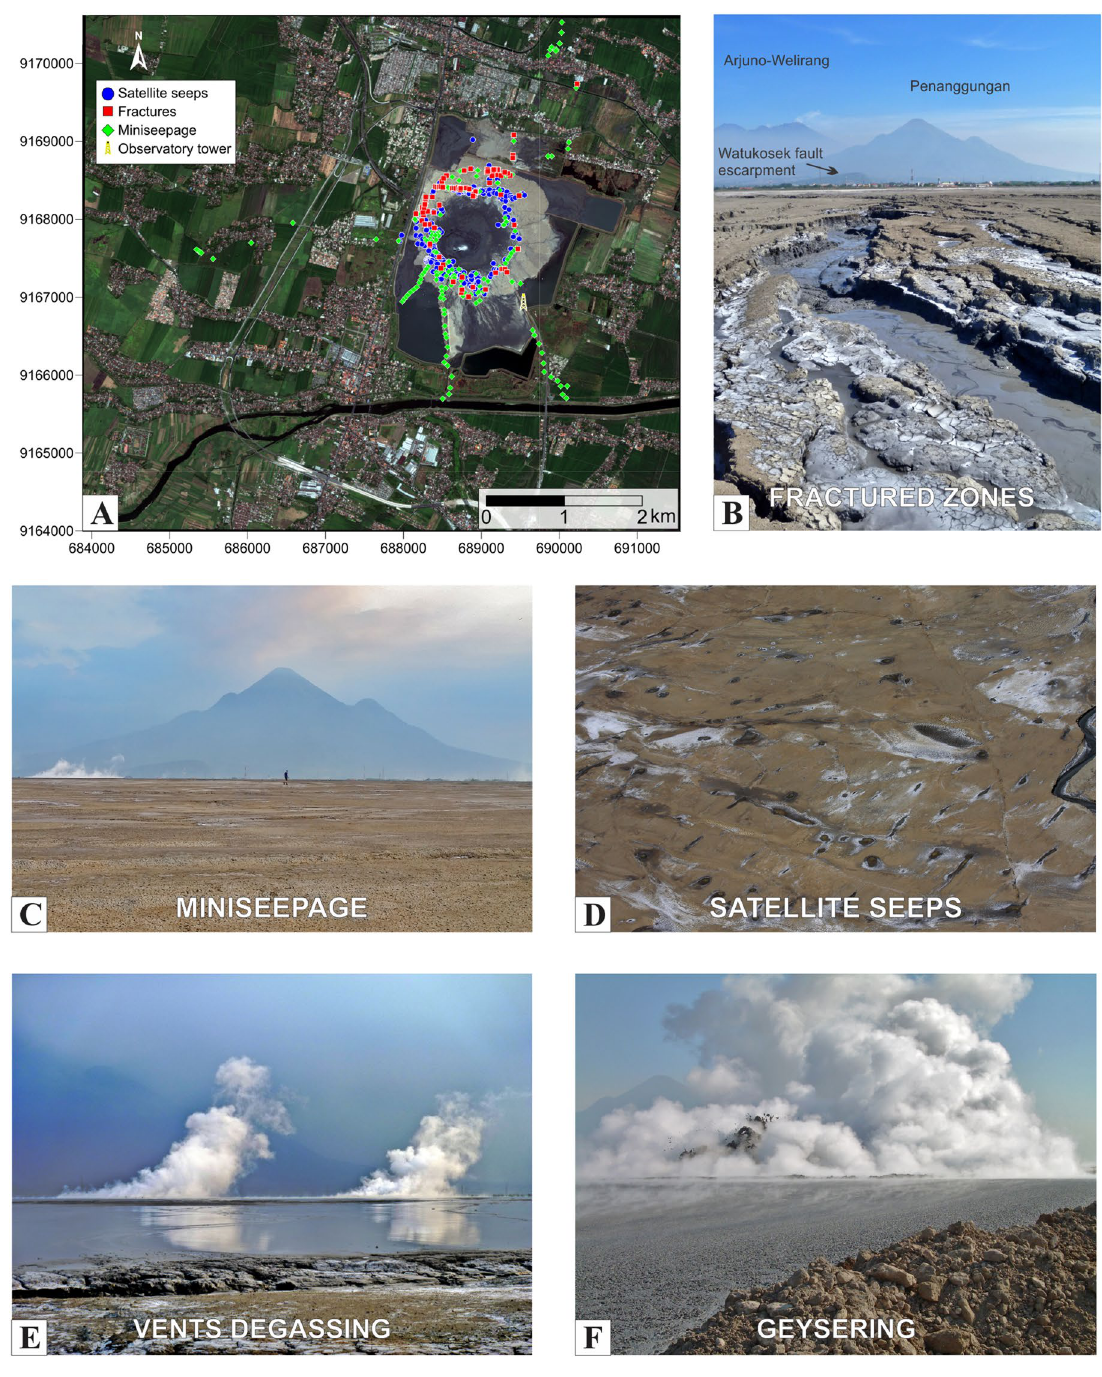
Figure 2. Measurements and identified gas release sources at Lusi. ( A ) High resolution Ikonos satellite image of Lusi area in August 2014 with additional overlaid basemap constructed using Esri ArcGIS ArcMap 10.2.1. Symbols indicate the positions, and the equivalent degassing modes, of the flow measurements done with accumulation chamber. ( B – E ) The four main degassing modes identified in this study: ( B ) fractured zone extending in NE–SW direction towards the volcanic complex in the background; ( C ) field view of the vast region where miniseepage occurs in undisturbed surface; ( D ) aerial view of dozens of satellite seeps (for scale the stream on the right side is ~ 1 m wide); ( E ) the two active vents during regular activity, view from the edge of the not accessible pond. ( F ) Example of geysering